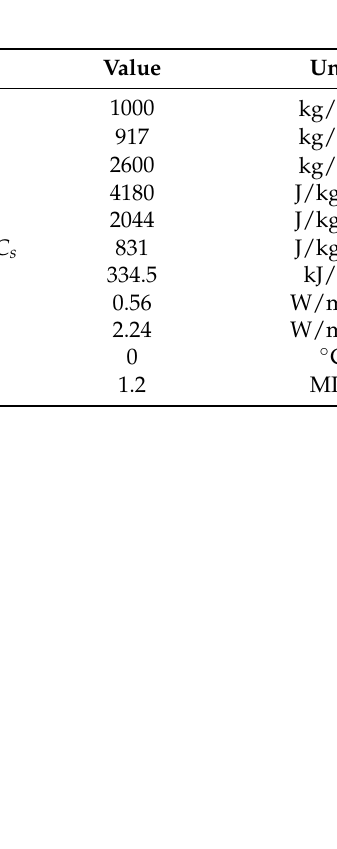
that the numerical model used in this study is reliable.